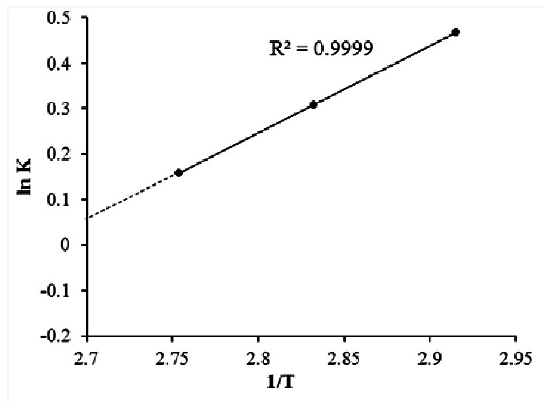
Fig. 6. Arrhenius plot for concentrate leaching